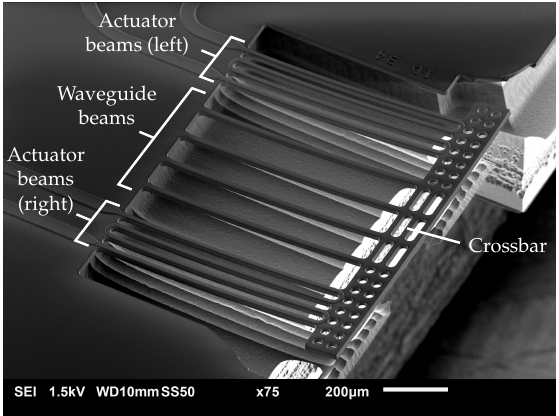
Figure 6. SEM image of a realized positionable waveguide array with a poly-Si thickness of 3 µm.